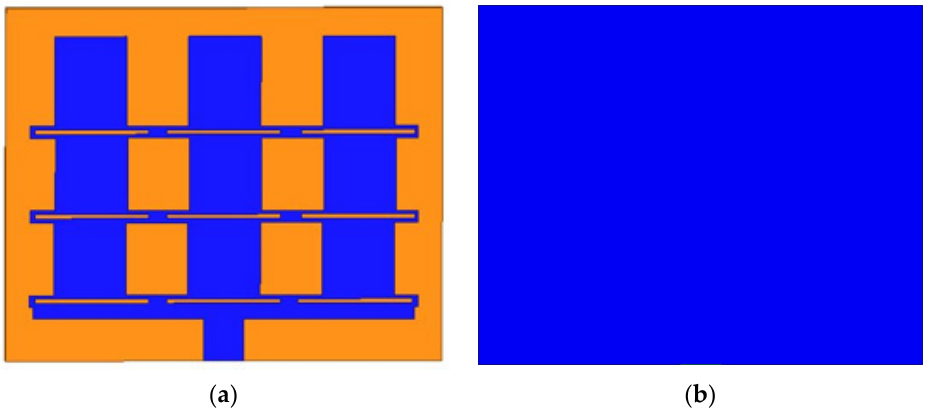
Figure 2. ( a ). Top view of the antenna (M ) showing the patch array structure of the antenna, ( b ) bottom view of the antenna showing the full ground plane.